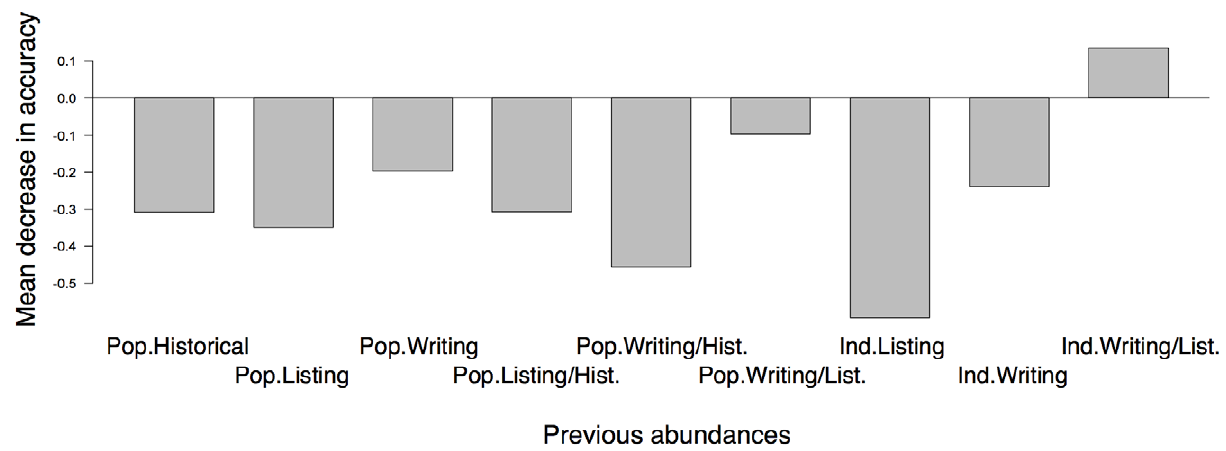
Figure 2. Abundance variable importance values. Variable importance for the previous abundance variables from the random forest analysis examining whether listed plant species can be grouped by previous abundances only, including both population-based and individual-based abundances (n=197). Variable importance is measured as the mean decrease in model classification accuracy when values for that variable are randomly permuted. Abbreviations: Pop.Historical=Number of historical populations, Pop.Listing=Number of populations at time of ESA listing, Pop.Writing=Number of populations at time of recovery plan writing, Pop.Listing/Hist.=Proportion of historical populations remaining at time of listing, Pop.Writing/Hist.=Proportion of historical populations remaining at time of plan writing, Ind.Listing=Number of individuals at time of listing, Ind.Writing=Number of individuals at time of plan writing, Ind.Writing/List.=Number of individuals at time of plan writing remaining at time of